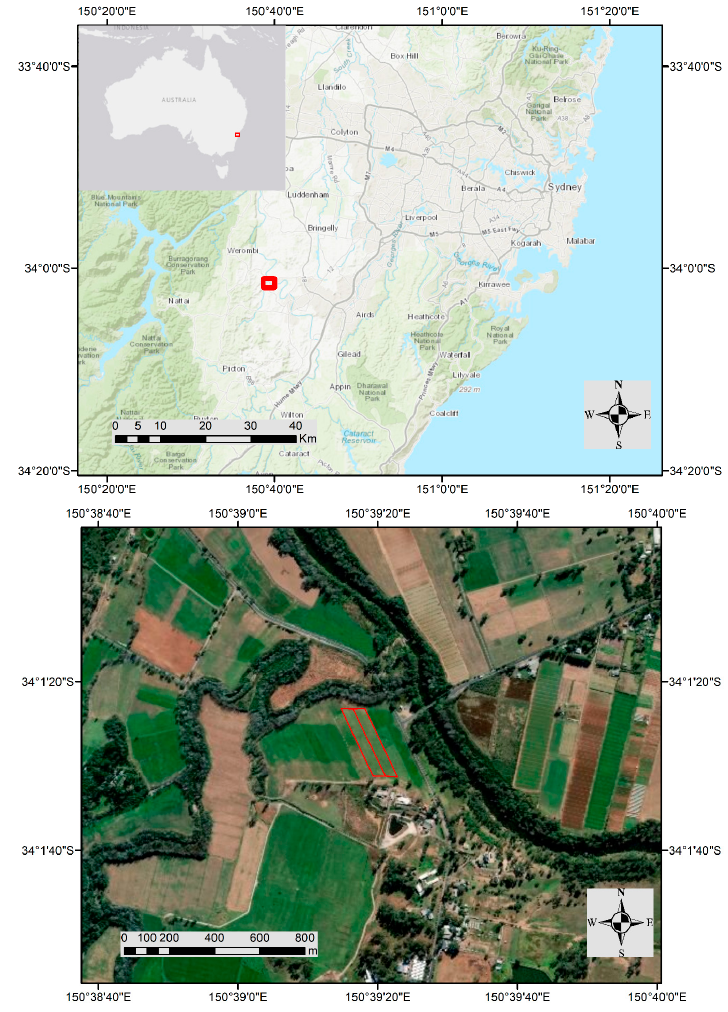
Figure 1. Location of the two paddocks evaluated in the study at the University of Sydney’s dairy farm (Camden, New South Wales, Australia). Maps were created using ArcMap ™